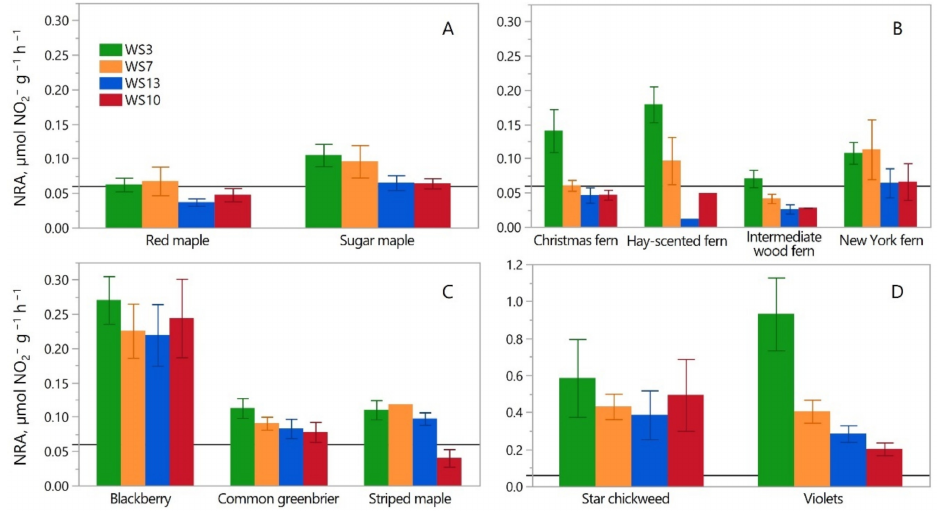
Figure 1. Mean summer foliar NRA in each watershed (WS) of overstory maple species ( A ) and common herb-layer species grouped by growth form: ferns ( B ), shrubs/vines and woody